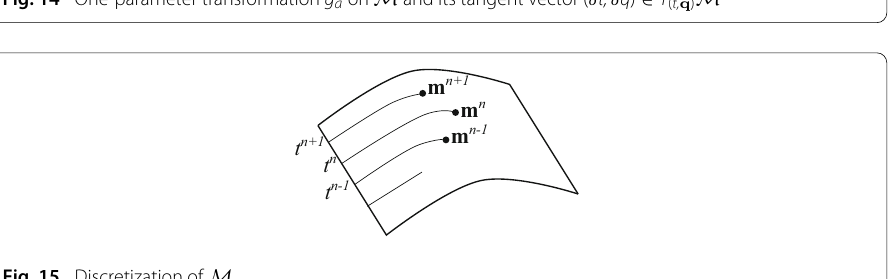
Fig. 14 One-parameter transformation g a on M and its tangent vector ( δ t, δ q ) ∈ T ( t, q ) M